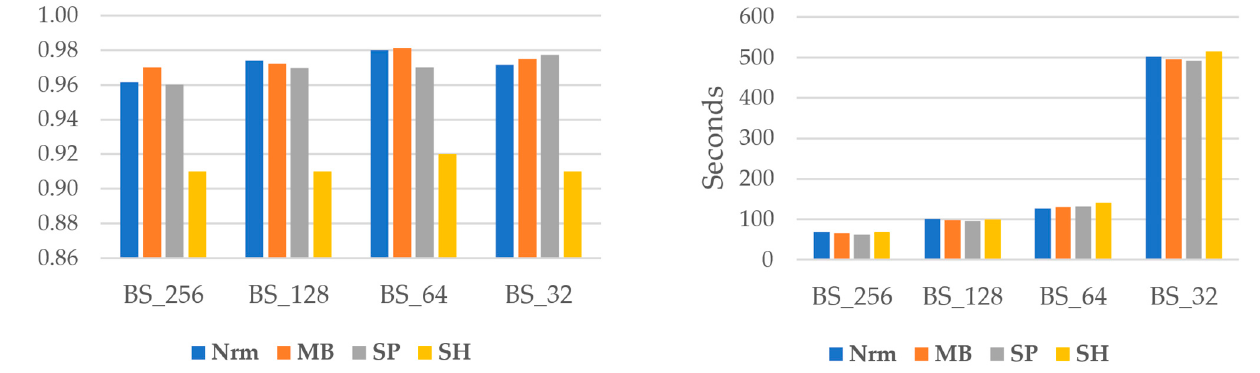
Figure 5. Comparison of overall F1Score and computation time.